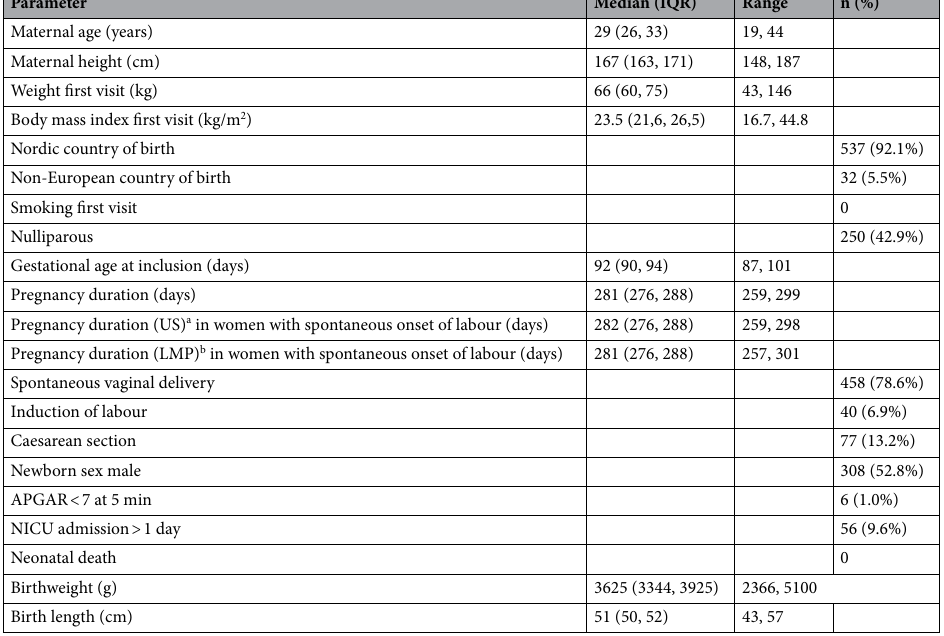
week 18–19, corresponding to the routine ultrasound scan, and week 37–39. The dating discrepancy, i.e. the difference between estimated date of delivery (EDD) according to BPD at first study visit and EDD according to last menstrual period, was within ± 7 days, and thereby fulfilled the inclusion criteria. The mean discrepancy was − 0.1 days (SD 2.8 days) and the median discrepancy was 0 days. The dating discrepancy was slightly, but not statistically significantly, larger for girls than boys (p = 0.174); mean − 0.5 days for girls (SD 2.7 days) and 0.2 days for boys (SD 2.7 days), respectively. Further, there was a difference in dating discrepancy between the study sites (p < 0.001), with the lowest discrepancy in Katrineholm (mean 0.1 days, SD 2.4 days) and the largest in Västerås (mean − 1.2 days, SD 2.8 days). The median age of the participating women was 29 years. BMI covered a range of 16.7–44.8 kg/m 2 , with a median BMI of 23.5 kg/m 2 . The majority of the study population, 92%, were born in a Nordic country (Sweden, Norway, Denmark, Finland or Iceland), and 5.5% were of non-European origin. Nearly 43% of the women were nulliparous. The median pregnancy duration was 281 days. Data on neonatal characteristics, including sex, was available for 574 children (98.5%). The median birthweight was 3625 g and median birth length 51 cm. For children with a mother born in a Nordic country, the median birthweight was 3628 g, compared with 3600 g for children with a mother born in a non-Nordic country; a difference that was not statistically significant (p = 0.258) . Likewise, the median birthweight was comparable in children with younger and older mothers; 3660 g for mater- nal age less than 35 years and 3624.5 g for maternal age 35 years or older, p = 0.908. Nulliparous women gave birth to children with lower median birthweight compared with parous women; 3540 g for nulliparous and 3714 g for parous women, p = 0.008. Maternal and neonatal characteristics are summarized in Table 1. The median and variance of the different biometric measurements for each gestational week are shown in Tables 2, 3, 4, 5, 6, 7, 8, 9, 10, and 11. The variance is expressed in standard deviations (+ 3 SD, + 2 SD, + 1 SD, median, − 1 SD, − 2 SD and − 3 SD) and in percentiles (2.5th, 5th, 10th, 25th, median, 75th, 90th, 95th and 97.5th). Table 2 shows the median and variance for estimated BPD by GA in SD, and Table 3 BPD by GA in percentiles. Figure 2a shows the raw data with fitted percentiles for estimated BPD by GA. Mean and variance equation for BPD in males and females: